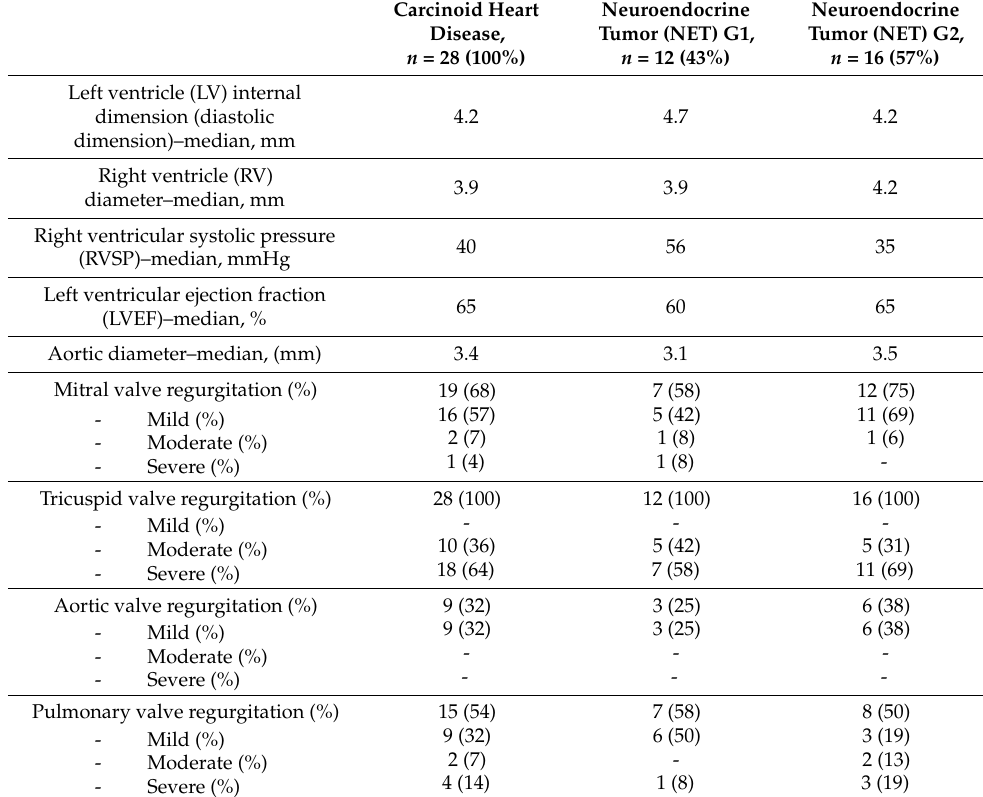
Table 3. Patients with CHD–echocardiographic